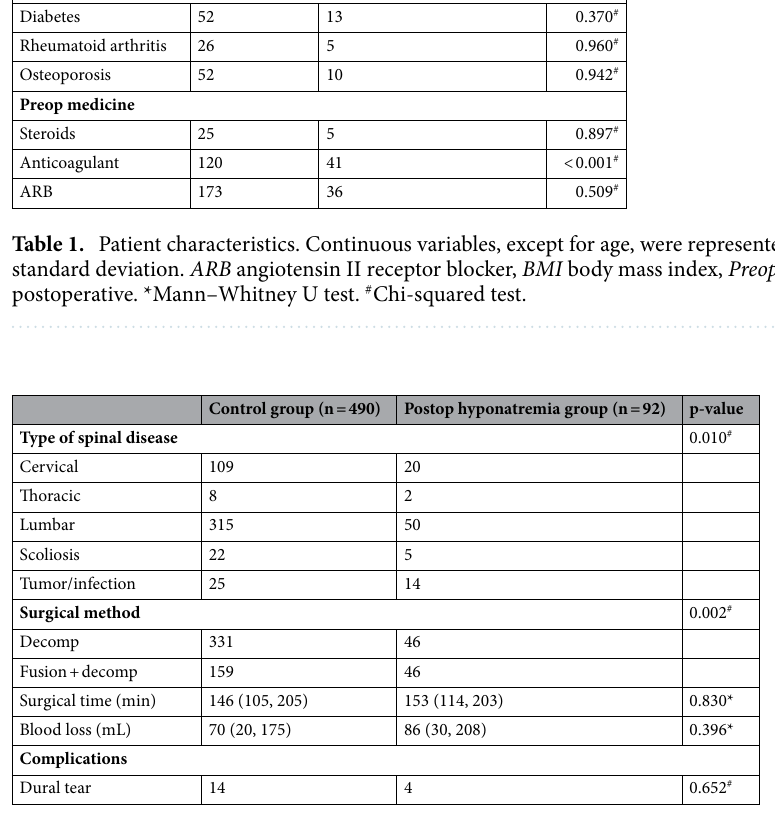
Table 2. Surgical characteristics. Continuous variables were represented by the median with 1st and 3rd quartiles. Decomp decompression, Postop postoperative. *Mann–Whitney U test. # Chi-squared